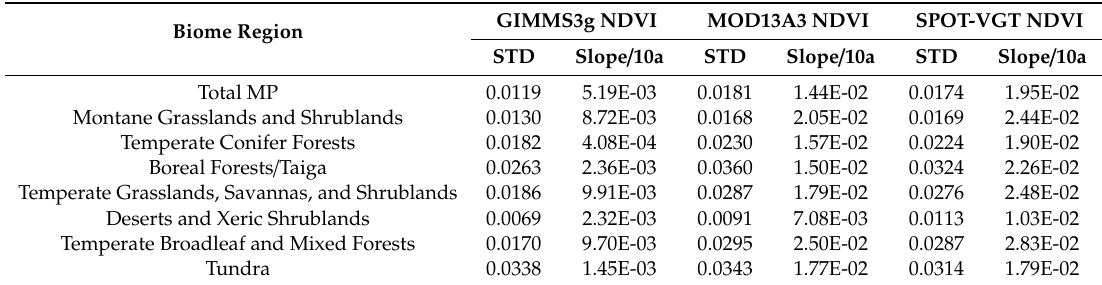
Table 5. Standard deviation (STD) and slope of primary linear regression of deseasonalized NDVI values in the di ff erent biomes of the MP.